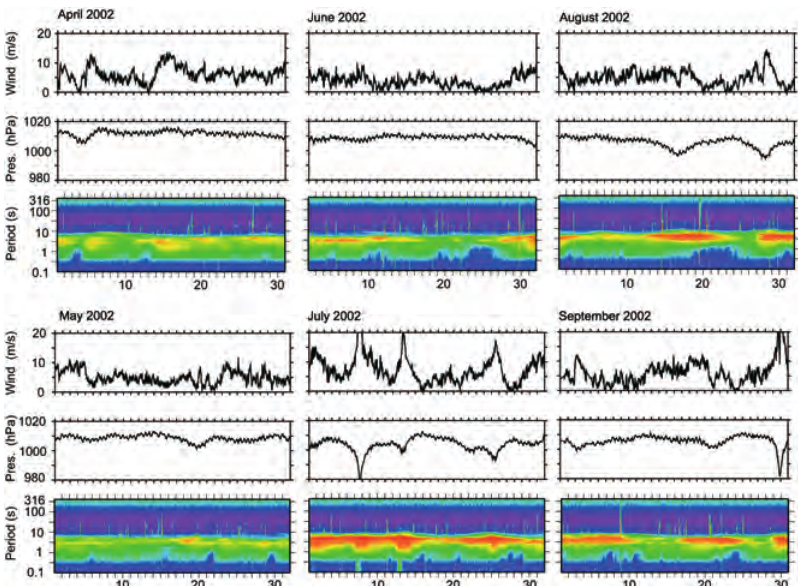
Fig. 9a. Comparison between the noise spectra of vertical component of the WP-1 and the meteorological da- ta (average wind speeds and air pressure) observed at Okinotori-shima, which lies about 150 km northeast of WP-1: from April to September 2002. Rapid decreases of air pressure indicates typhoon passing. The wind speed appears to be related to noise levels in periods around a few